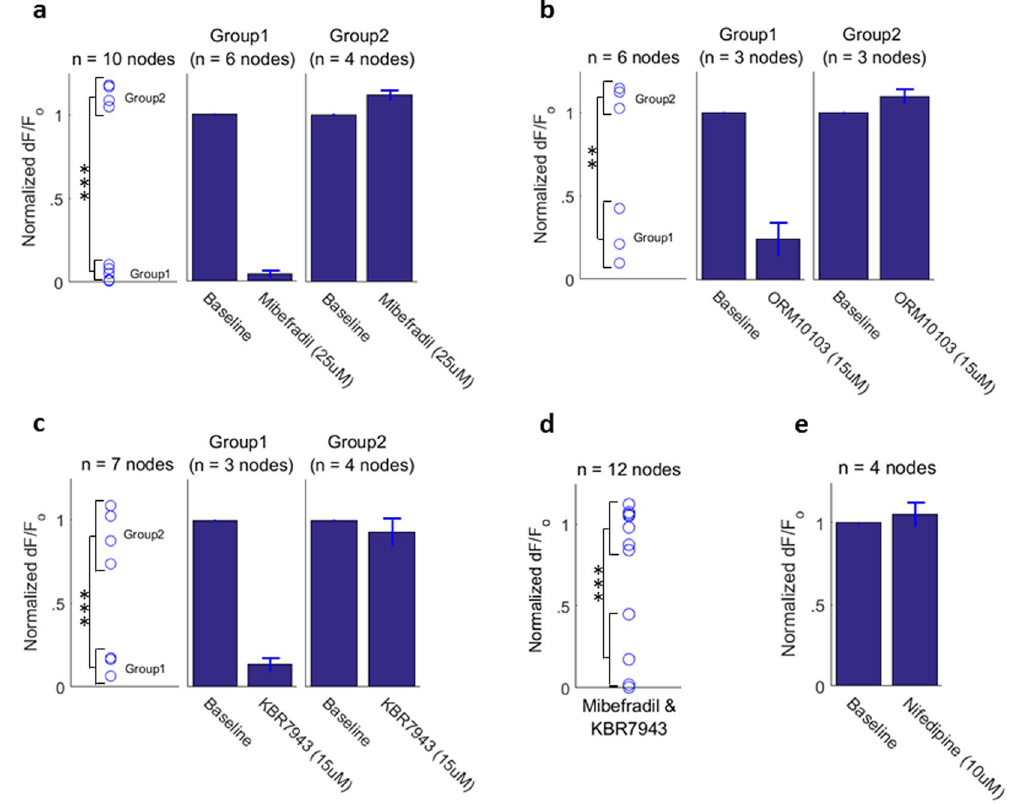
Figure 7. Ca V channel and NCX blockers show differential inhibition of activity-dependent calcium response. ( a ) T-type Ca V channel blocker mibefradil (25 μ M) nearly abolishes the calcium signal in some nodes while other nodes are unblocked. ( b ) NCX inhibitors ORM10103 (15 μ M) and ( c ) KBR7943 (15 μ M) also show differential blockage: a set of nodal signals are significantly diminished while others show little or no blockage. ( d ) Co-application of mibefradil and KBR7943 shows similar results as seen for single drug application. ( e ) Activity-dependent calcium signals were not blocked or diminished by 10 μ M nifedipine (L-type inhibitor). (Recordings from each data panel came from 2–4 mouse